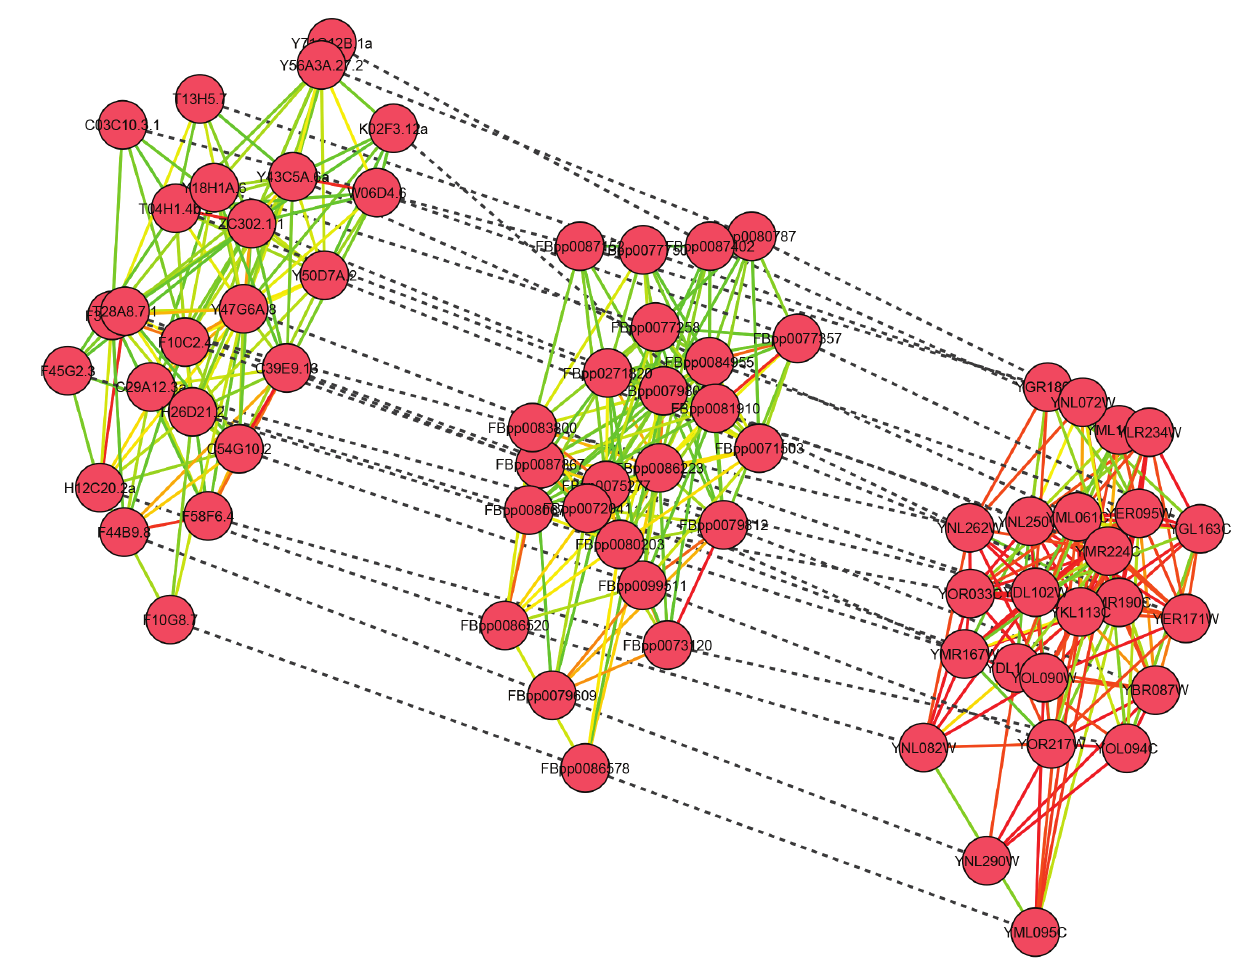
Figure 2. Alignment of DNA repair complex in C. elegans , D. melanogaster and S. cerevisiae